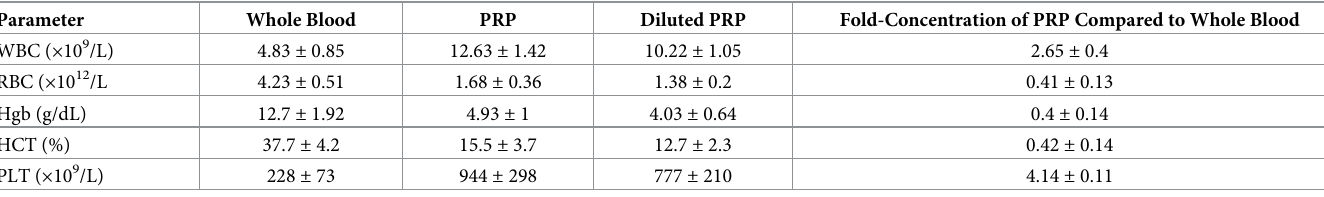
Table 1. Cell composition and fold concentration of PRP prepared using the Harvest system. Parameter